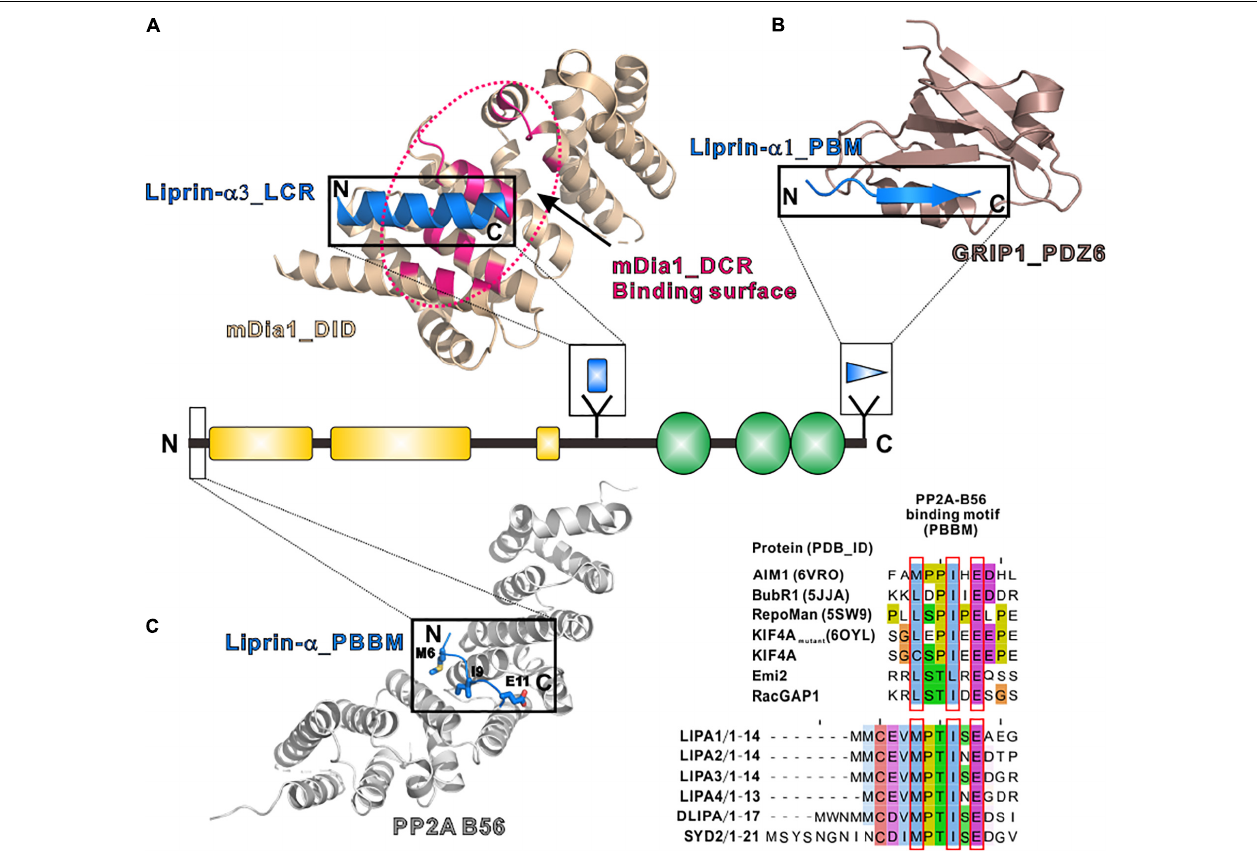
FIGURE 4 | Additional regions of liprin- α in protein–protein interactions. (A) The structure of the LCR in complex with mDia (PDB id: 4UWX). Base on another solved structure of mDia (PDB id: 2BAP), the surface on mDia that is involved in the autoinhibition formation was highlighted by a dotted hotpink circle, showing the two binding sites are largely overlapped. (B) The structure of the PBM in complex with the PDZ6 domain of GRIP1 (PDB id: 1N7F). (C) The manually modeled structure of the PP2A-B56/liprin- α _PBBM complex. The sequences of the PBBMs from different proteins in the solved structures were aligned with the PBBMs of liprin- α s. The residues that are involved in B56 binding were highlighted by red